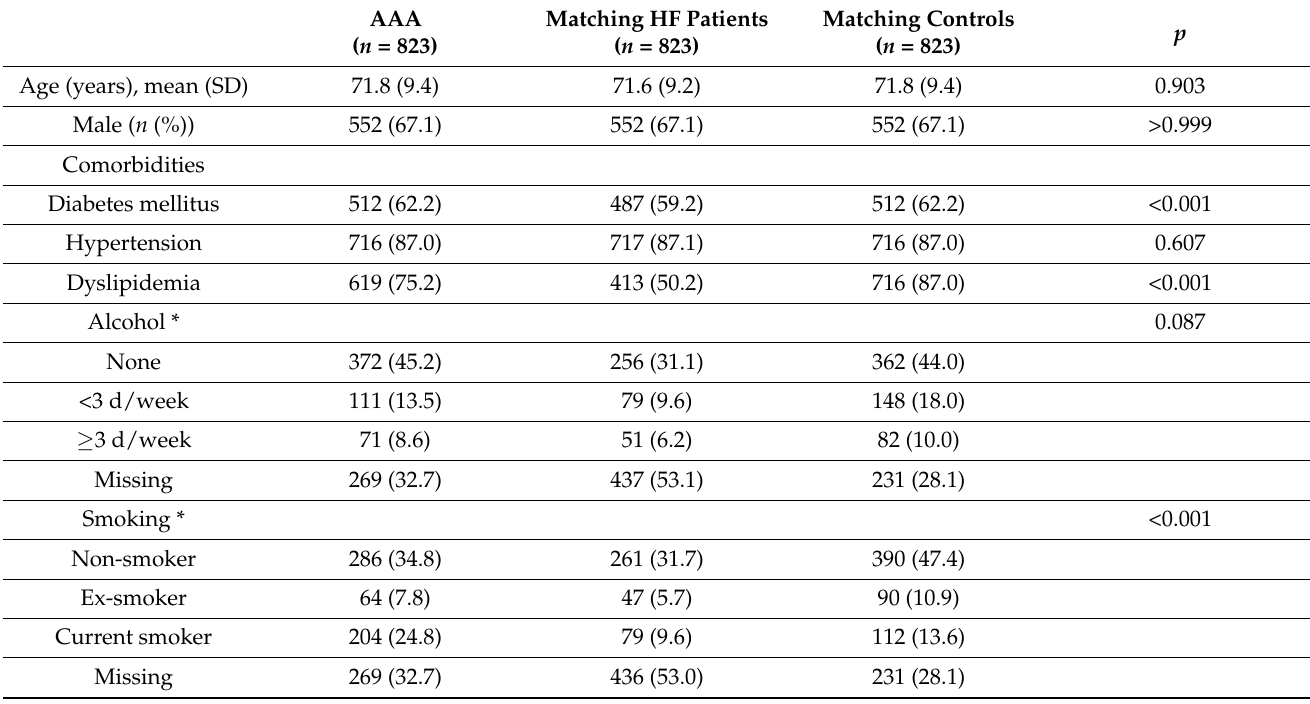
Figure 1. Flow diagram. Table 1. Baseline clinical characteristics of the patients.